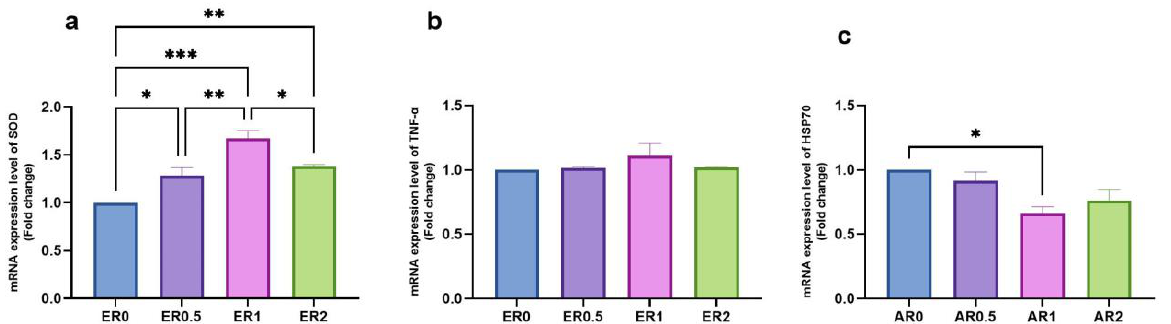
Figure 6. The relative expression profile of SOD ( a ), TNF-α ( b ), and HSP70 ( c ) genes of Red tilapia fed different dietary levels of ER. Values are expressed as mean ± SE from triplicate groups. p values of one-way ANOVA followed Tukey’s post hoc test for significant differences. p < 0.05 (*), p < 0.01 (**), and p < 0.001 (***) between different treated groups.